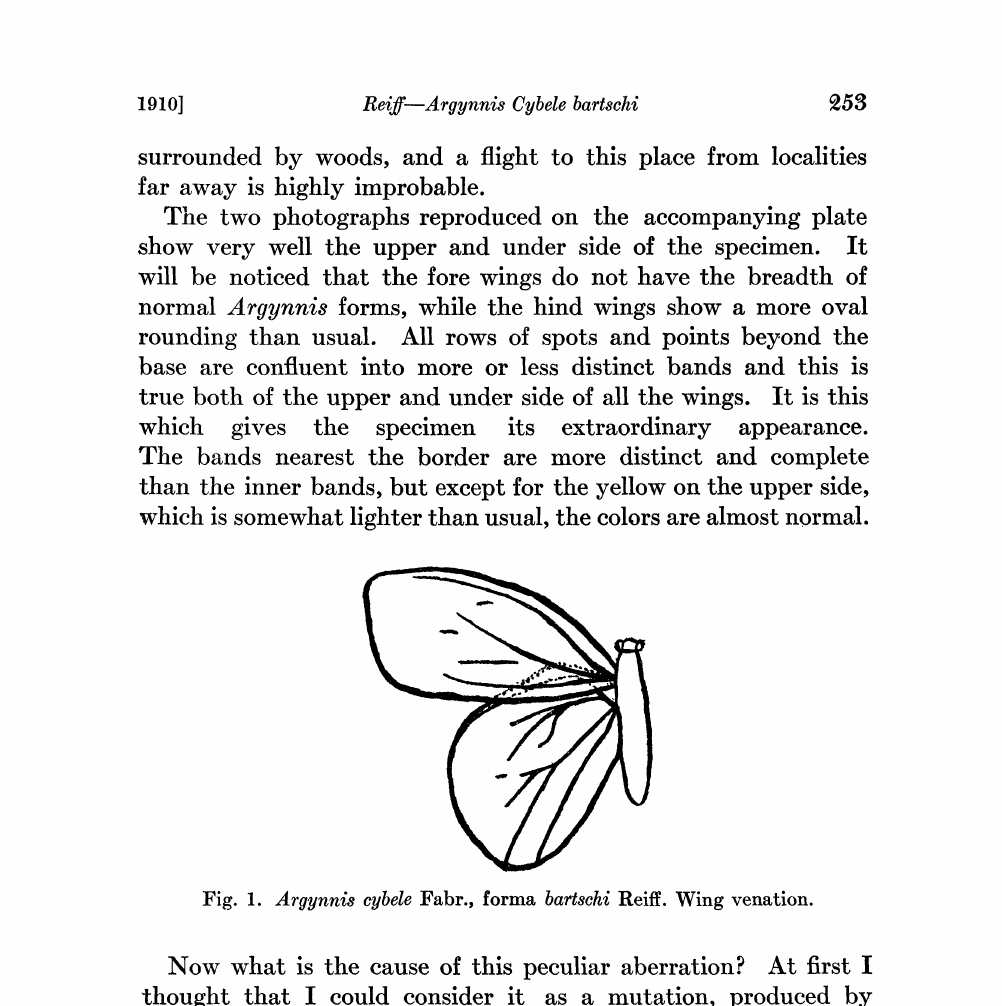
Fig. 1. Argynnis cybele labr., forma bartschi Reiff. Wing